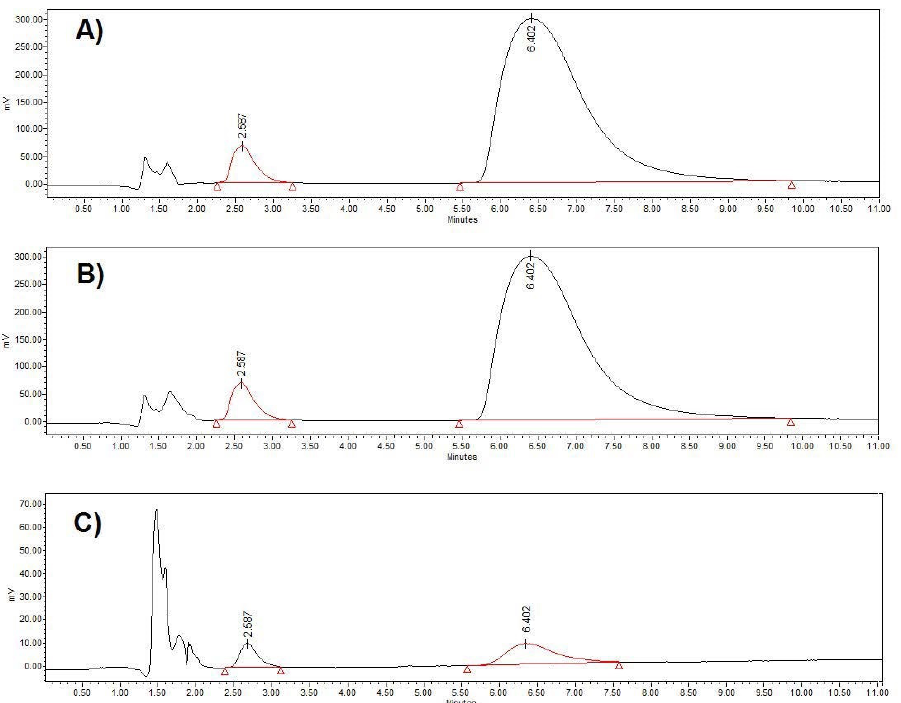
Figure 3. Representative chromatograms of ( A ) standard sample, ( B ) sample obtained from the dissolution study of formulation A from the 6.8 pH medium and ( C ) sample obtained from the dissolution study of formulation B from the 1.2 pH medium. NTX · HCl was eluted at 2.56 min and BUP · HCl was eluted at 6.40 min.